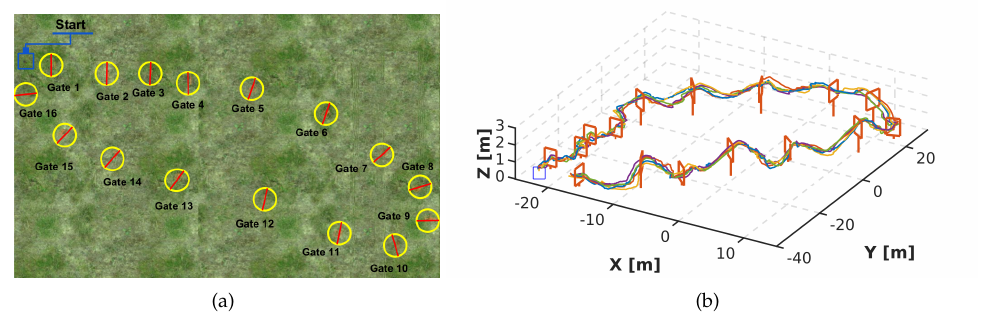
Figure 23. Third racetrack to evaluate DeepPilot using a mosaic of 6 frames. The track spans over a surface of 70 m × 40 m, and the space in between gates goes from 6 m to 15 m. Note that this track was not used for training. ( a ) The track is formed by 16 gates: 8 gates of 1.2 m high and 8 gates of 2 m high. ( b ) Drone’s trajectories obtained for 5 runs for this racetrack. DeepPilot piloted the drone in the track providing the flight commands ( φ , θ , ψ , h ) . A video illustrating the performance of our proposed DeepPilot in this racetrack can be found at